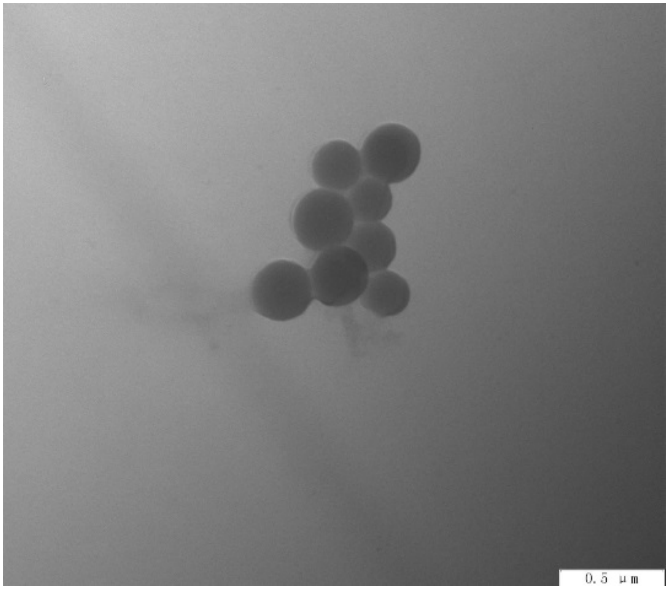
Figure 9. TEM morphology of N-2-HACC NPs.